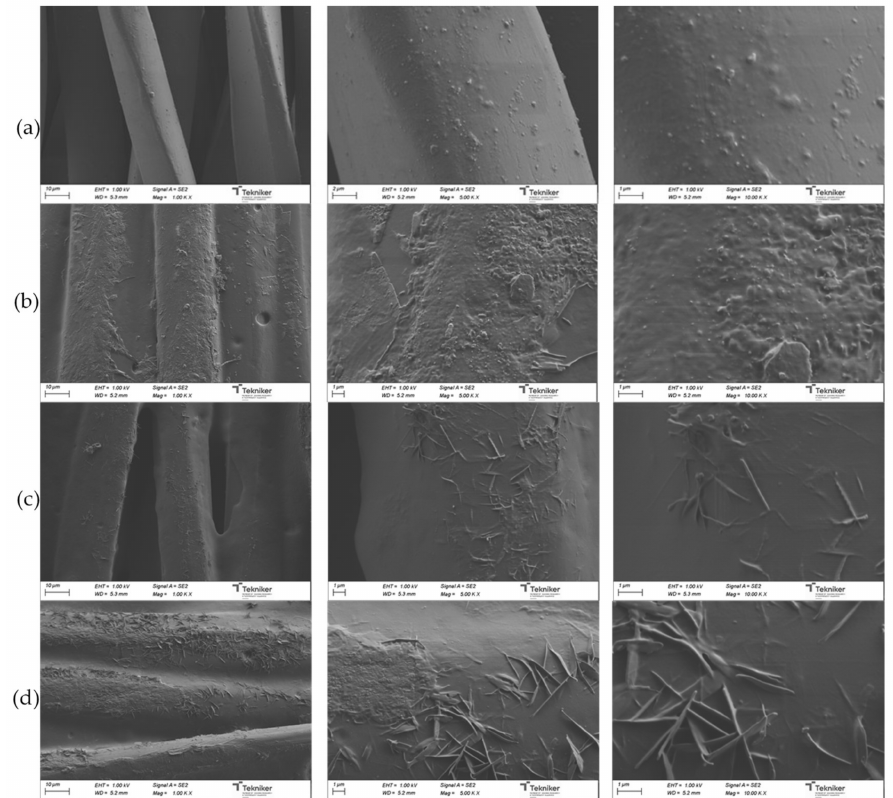
Figure 21. SEM micrographs for ( a ) uncoated UPRON fabric and UPRON fabrics coated with selected printing pastes: ( b ) 3294IPDI-2, ( c ) 3294IPDI-2 doped with 0.05 wt. % SWCNT, and ( d ) 3294IPDI-2 doped with 0.1 wt. %